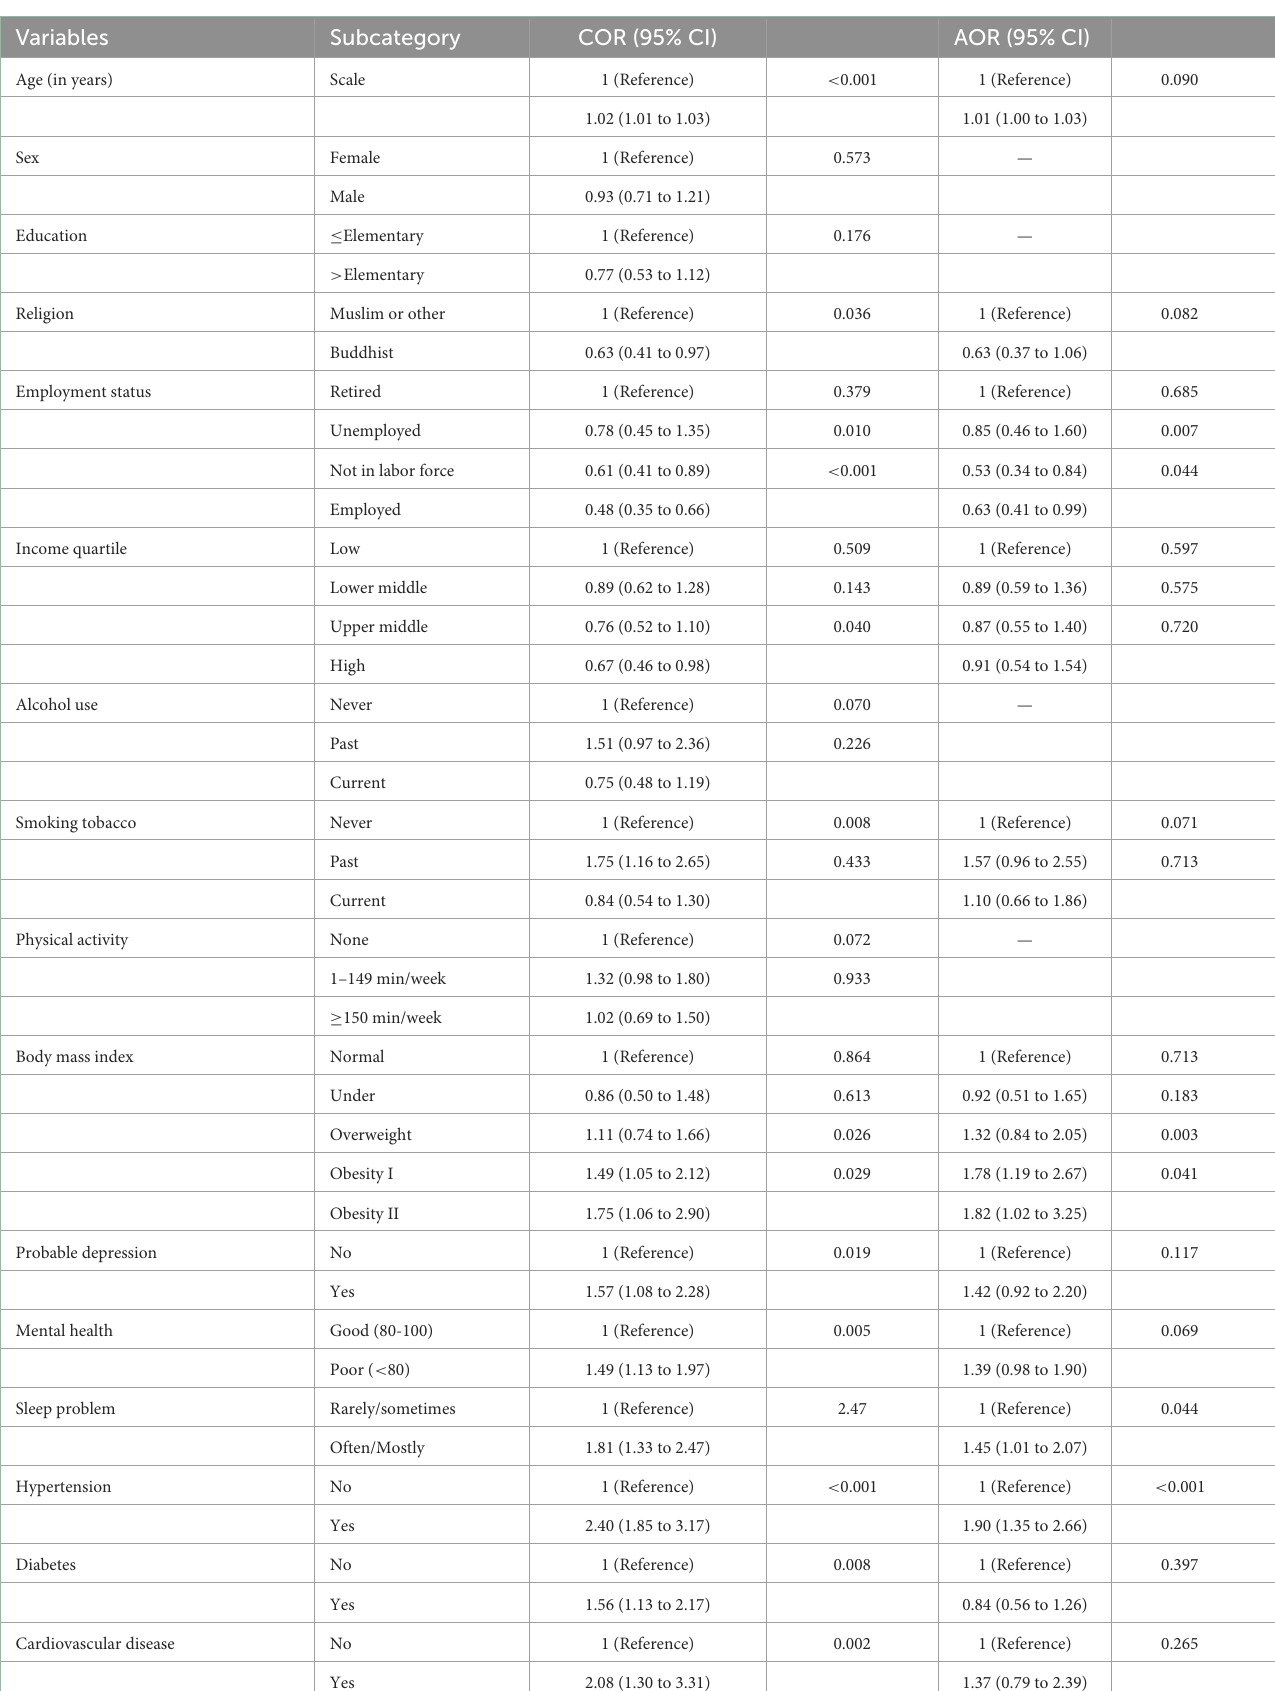
TABLE 2 Cross-sectional associations with arthritis, Health, Aging, and Retirement in Thailand